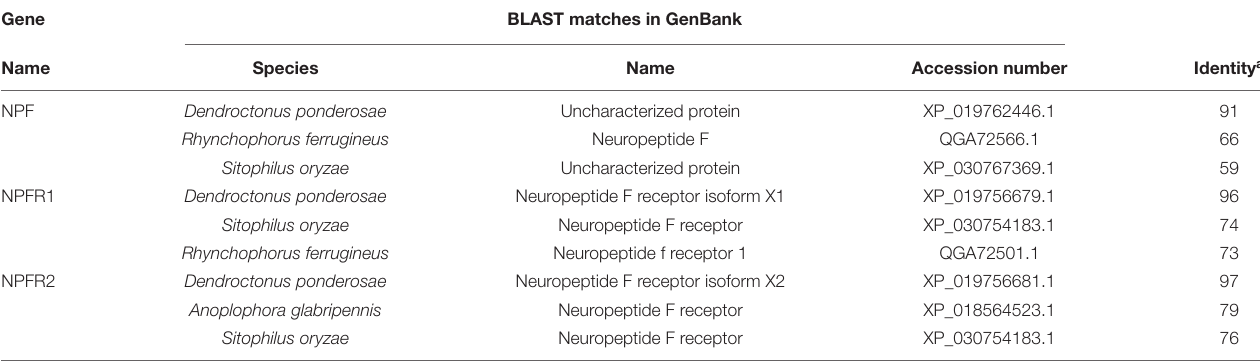
TABLE 2 | Identity of NPF and NPFR genes from D. armandi with relevant gene sequences in other insect species. Gene BLAST matches in